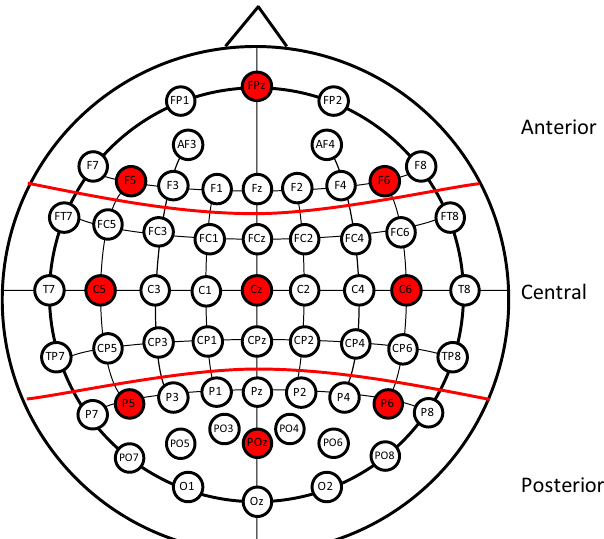
Figure 2. Electrodes and regions used in the analyses. The electrodes highlighted in red correspond to the example electrodes in the other pictures including in the Supplemental Materials unless otherwise